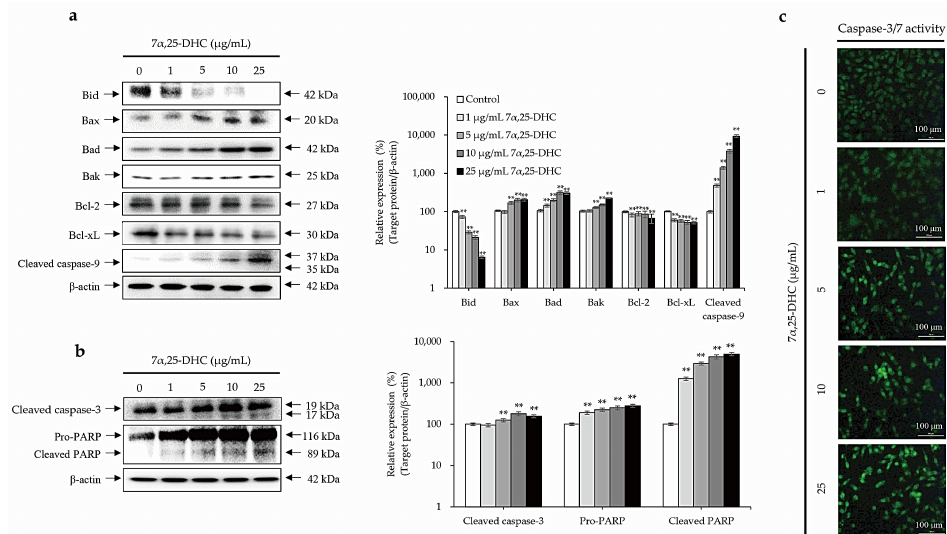
Figure 5. 7 α ,25-DHC-induced cell death was involved with the intrinsic apoptosis pathway in L929 cells. L929 cells were incubated with 1, 5, 10, and 25 µ g/mL 7 α ,25-DHC for 48 h. Total proteins were extracted using cell lysis buffer and then quantified by BCA assay kit. Sequentially, equal concentrations of protein samples were loaded onto SDS-PAGE gels to perform Western blotting using antibodies against pro- and antiapoptotic molecules. Thereafter, immunoreactive bands were exposed by ECL solution and acquired under microChemi 4.2. Results are presented as the relative ratio of target protein/ β -actin, ** p < 0.01. β -actin was used as an internal control. ( a ) 7 α ,25-DHC induced mitochondria-dependent intrinsic apoptosis in L929 cells. ( b ) Cleaved caspase-9 induced cell death through the activation of caspase-3 and PARP in the L929 cells treated with 7 α ,25-DHC. ( c ) The activity of caspase-3 was increased by 7 α ,25-DHC in L929 cells. Cells with activated caspase-3 were stained as green fluorescence by the cell-permeable fluorogenic substrate PhiPhiLux-G 1 D 2